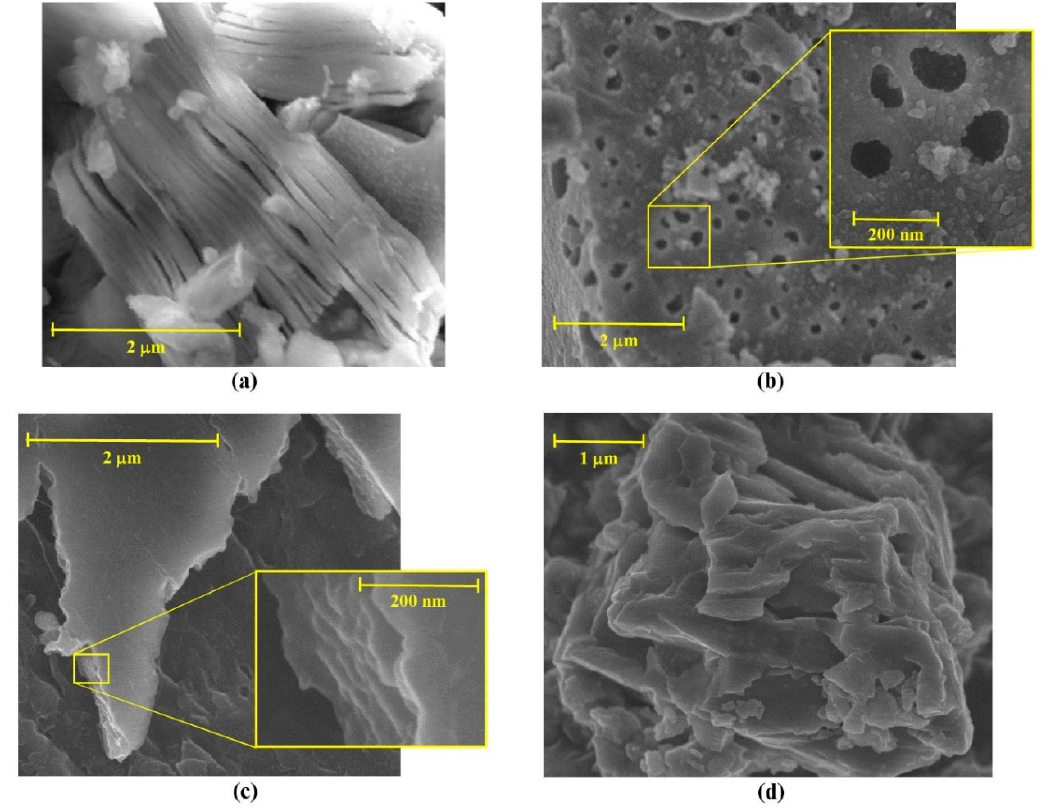
Figure 3. SEM photographs of ( a ) Ti 3 C 2 T x MXene after 4 h MC etching, ( b ) terephthalate-pillared MXene, ( c ) imidazole-pillared MXene, ( d ) oxalate-pillared MXene. Rietveld refinement of peaks at 9° and 6° at diverse milling times (Figure 2b) clearly